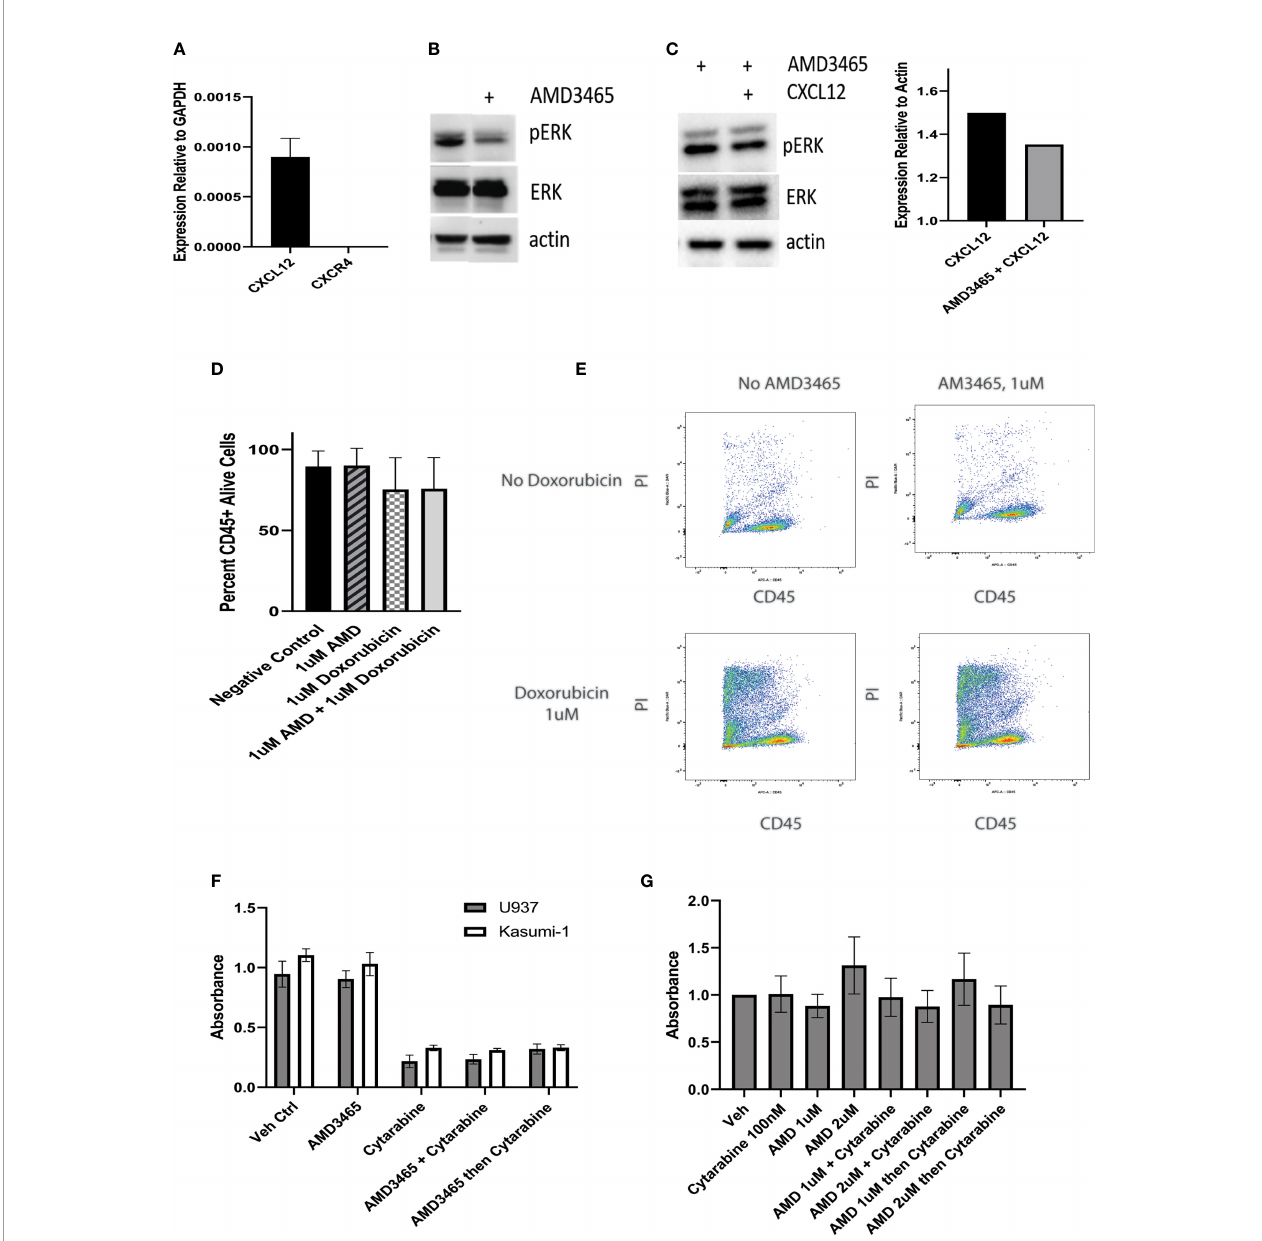
FIGURE 3 | Effect of CXCR4 inhibition on cell proliferation. U937 cells are kept in co-culture with human mesenchymal stem cells (hMSCs) and the cytotoxic effect of a CXCR4 inhibitor, AMD3465 is examined. (A) The expression of CXCL12 and CXCR4 in hMSCs is shown, normalized to GAPDH. (B) AMD3465 produces a decrease in pERK/ERK in U937 cells kept in co-culture in regular media. (C) The impact of AMD3465 on pERK/ERK in U937 cells kept in co-culture in charcoal stripped, phenol-free media in the presence of CXCL12 is shown by western blot, with corresponding densitometry. (D) The cytotoxic effect of AMD3465 is examined, both with and without doxorubicin. (E) Representative FACS data is shown. Propidium iodide (PI) staining delineates live versus dead cells, and CD45 positivity separates the CD45+ leukemia cells from the CD45- hMSCs. (F) The anti-proliferative effect of CXCR4 inhibition is evaluated by BrdU assay, with and without treatment dose cytarabine. (G) The anti-proliferative effect of high dose and low dose CXCR4 inhibition is evaluated by BrdU assay, with and without subtoxic dose